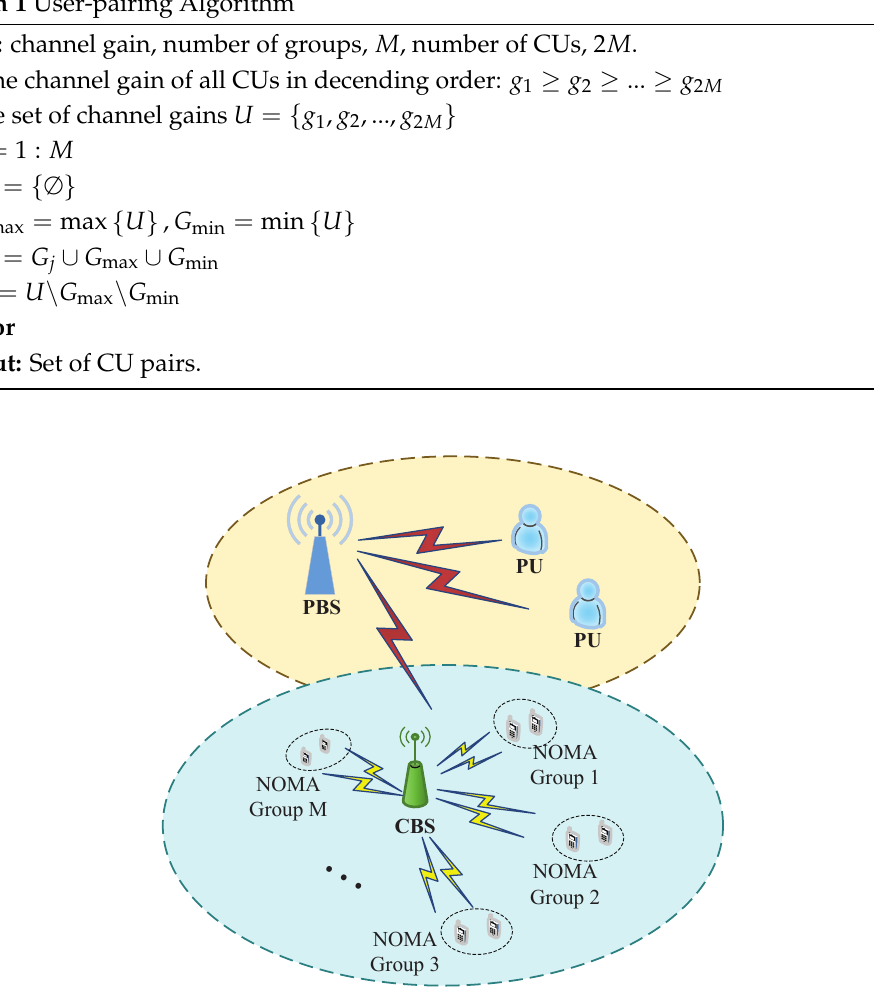
Figure 1. System model of the proposed